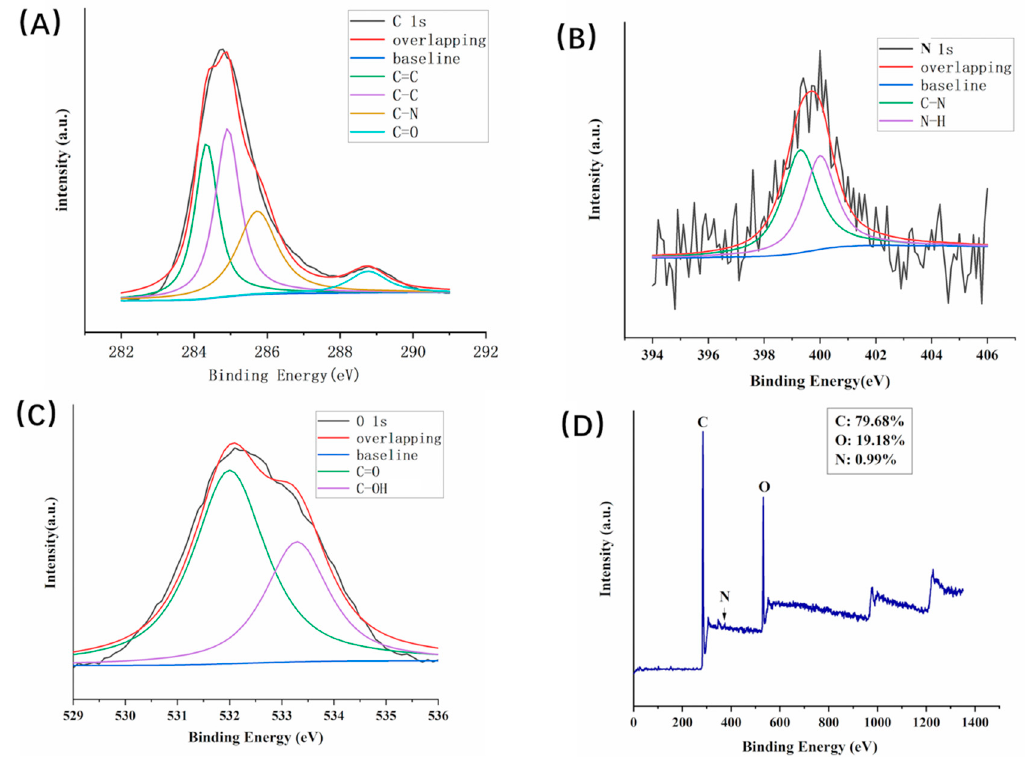
Figure 3. Surface composition and elemental analysis of the prepared PLR-CDs determined by XPS. High-resolution XPS spectra of ( A ) C 1s, ( B ) O 1s, and ( C ) N 1s peaks of the PLR-CDs. ( D ) Full-scan XPS spectrum of PLR-CDs.